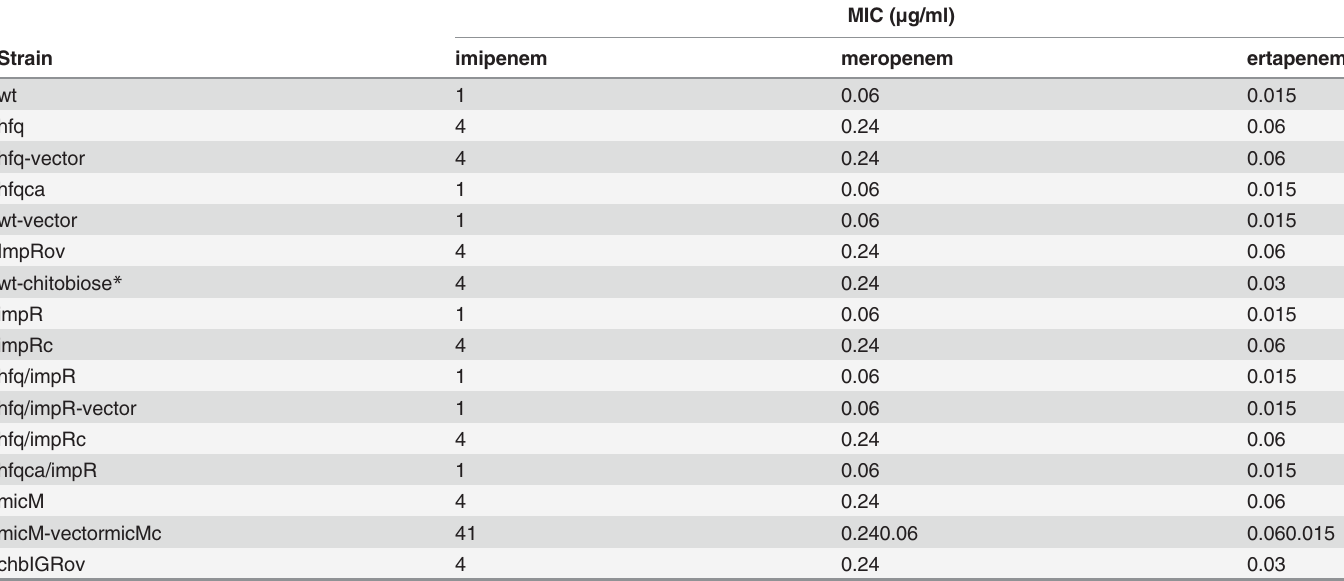
Table 3. MICs of imipenem, meropenem and ertapenem for P. mirabilis N2 and its derived